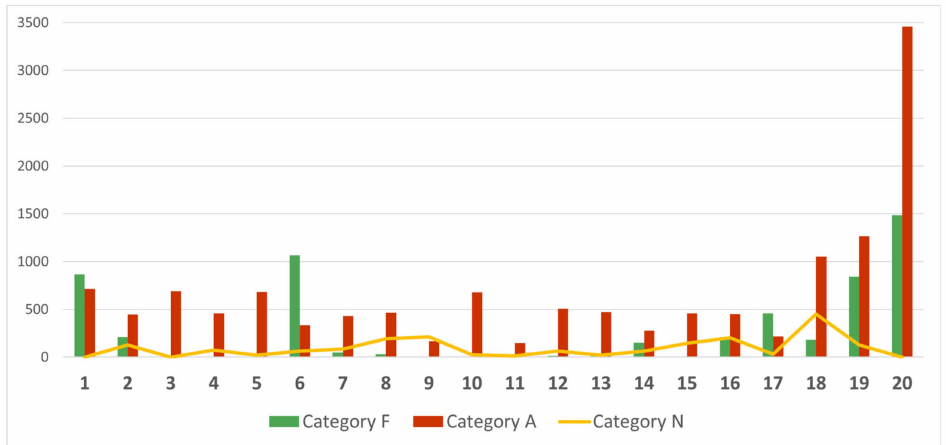
Figure 7. The summarised number of retweets received by top tweets identified for every week is divided into Category A (against vaccination mandate), Category F (in favour of vaccination mandate), and Category N (neutral or unidentified). For 17 out of 20 weeks, content belonging to Category A (against mandatory vaccination) was more